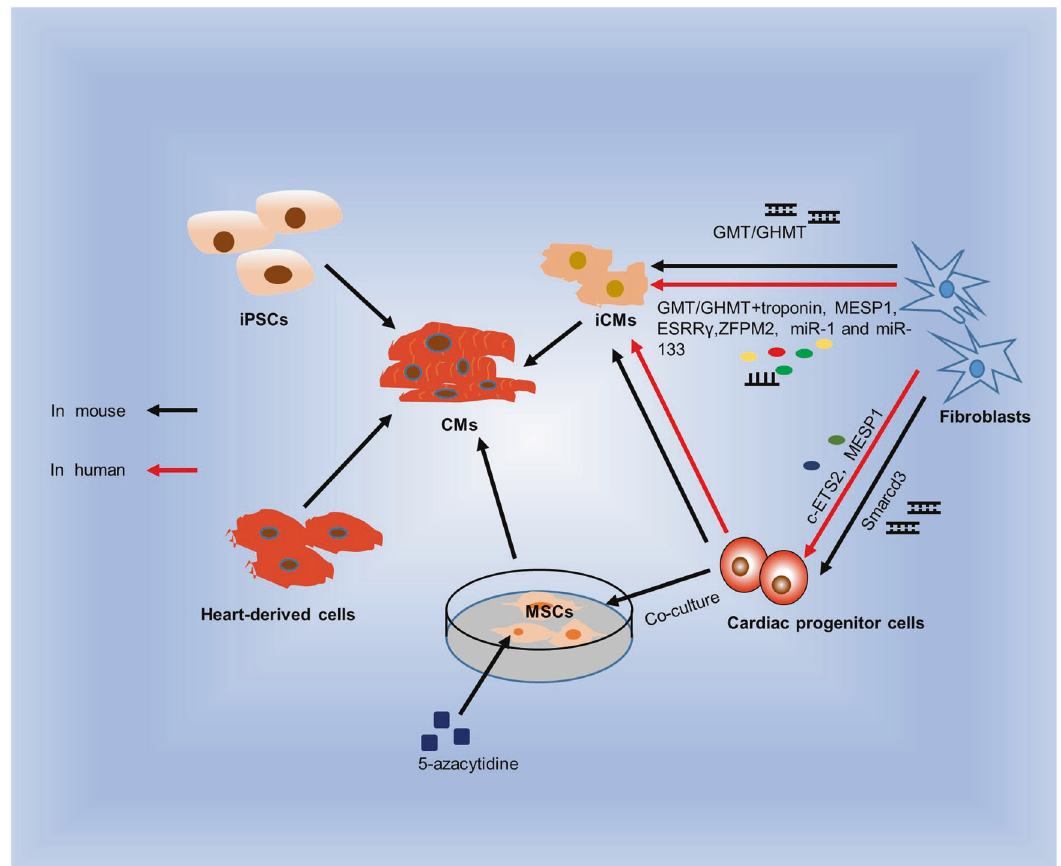
Fig. 3 Cell therapy of injured cardiac tissues. iPSCs can differentiate into functional cardiomyocytes in vitro. Heart-derived cells can differentiate into many types of heart cells. GMT or GHMT mixtures reprogram mouse fi broblasts to differentiate into iCMs, and Smarcd3 reprograms mouse fi broblasts to differentiate into cardiac progenitor cells in vitro. MSCs differentiate into CMs in the presence of 5-aza or in coculture with cardiac progenitor cells. However, reprogramming human fi broblasts requires GMT or GHMT mixtures and troponin, MESP1, ESRR γ and ZFPM2, was well as miR-1 and miR-133. Human fi broblasts can be transformed into cardiac progenitor cells with c-ETS2 and